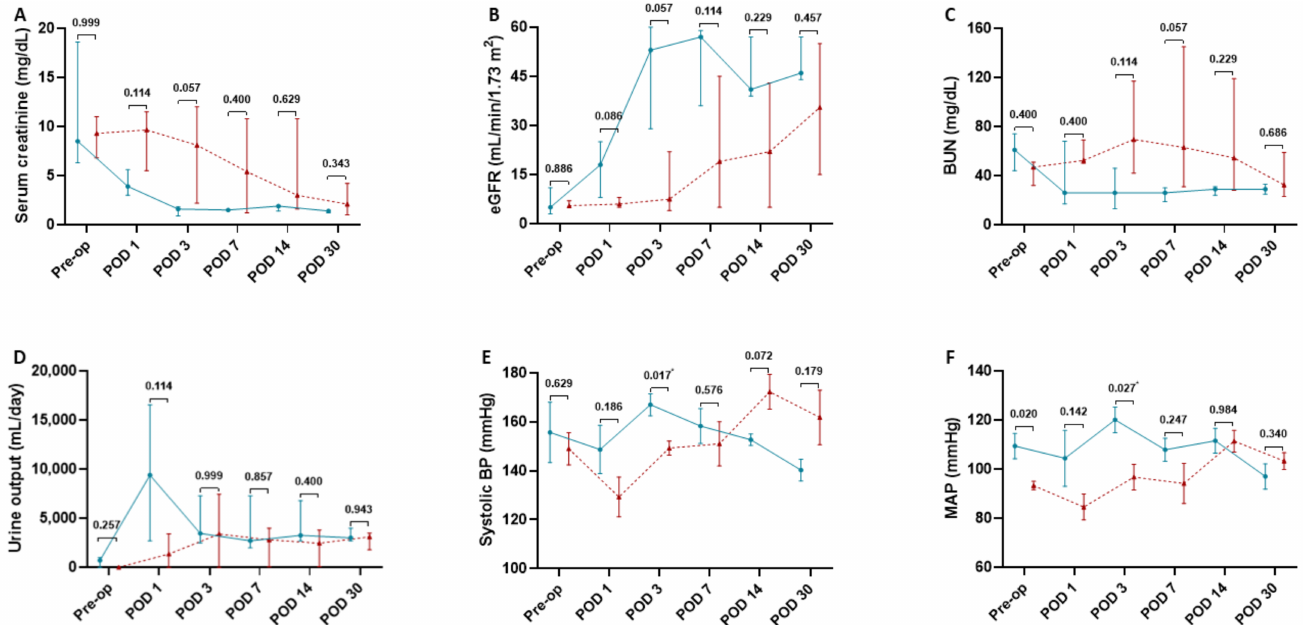
Figure 3. Renal function and hemodynamic parameters of living ( n = 3, solid turquoise line and closed circles) and deceased donor renal transplants ( n = 4, dash red line and closed triangles) before and after transplantation. Renal function and hemodynamic parameters of living and deceased donor renal transplants were measured preoperatively (pre-op) and on postoperative day (POD) 1, 3, 7, 14 and 30. ( A ) Serum creatinine levels. ( B ) Estimated glomerular filtration rate (eGFR). ( C ) Blood urea nitrogen levels (BUN). ( D ) Urine output. ( E ) Systolic blood pressure (BP). ( F ) Mean arterial pressure (MAP). The number above each time point represents the p -value of living vs. deceased donor renal transplants. * p < 0.05. Serum creatinine levels, eGFR, and BUN levels are expressed as median and range. Systolic BP and MAP are expressed as mean ±